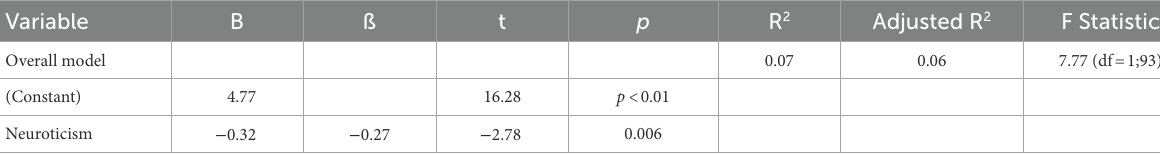
TABLE 4 Regression analysis summary for neuroticism predicting person–organisation fit.